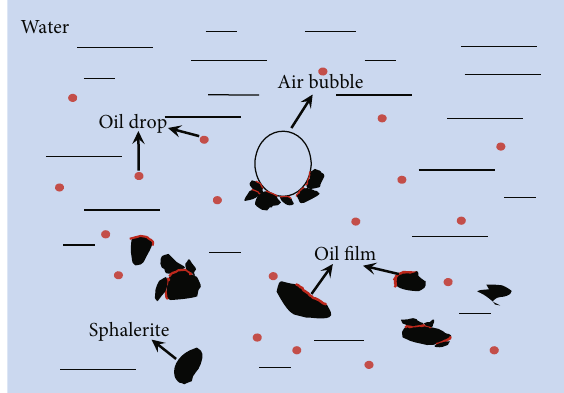
Figure 12: Diagrammatic sketch of the in fl uence of TO on the fl otation of